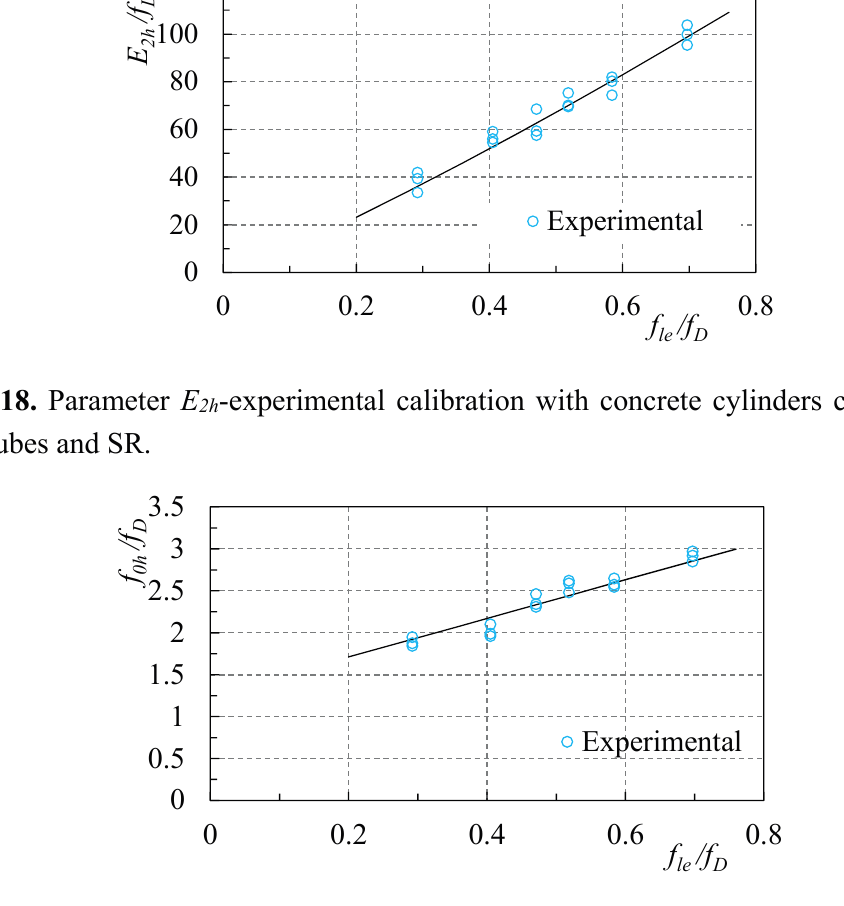
Figure 19. Parameter f 0h -experimental calibration with concrete cylinders confined with GFRP tubes and